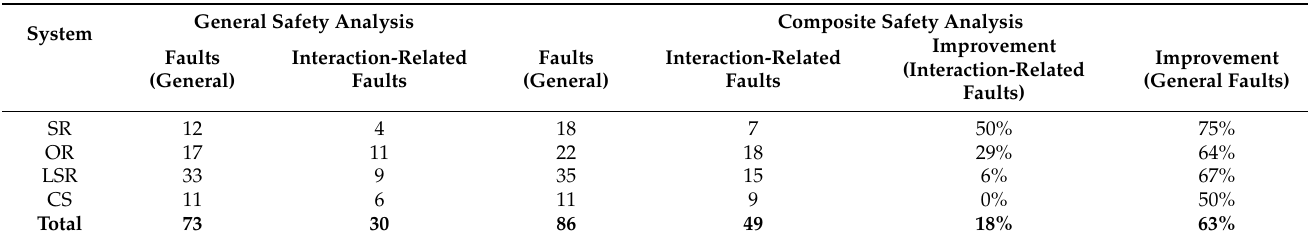
Table 2. Safety analysis with and without composite safety analysis.